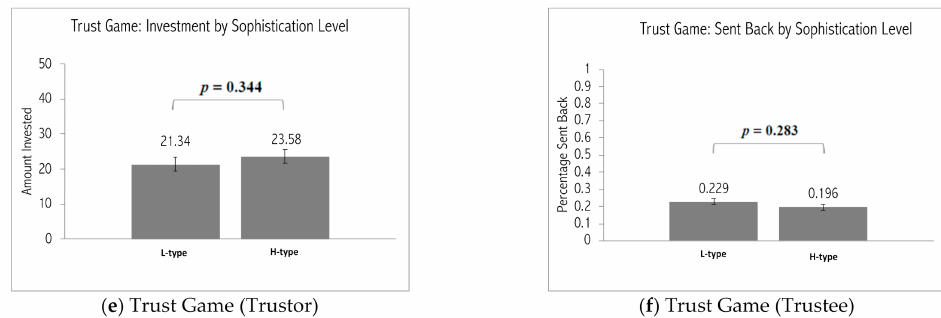
Figure 1. ( a – f ) Choices in the four games by sophistication levels. Table 5 goes one step further. It reports OLS regressions, allowing for a more compre- hensive parametric analysis. In this second analytical assessment, all the outcomes under C1 are regressed—in a between-subjects fashion—on a dummy variable, named H-dummy , that identifies subjects with a high level of lab-sophistication. This coefficient informs us